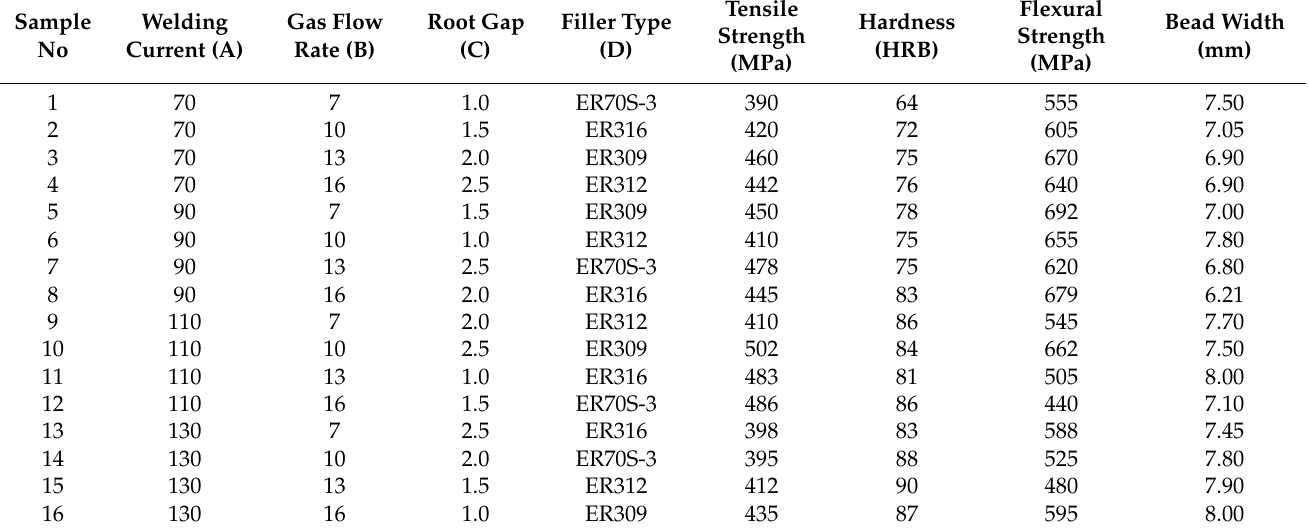
Table 23. Result table for all responses.